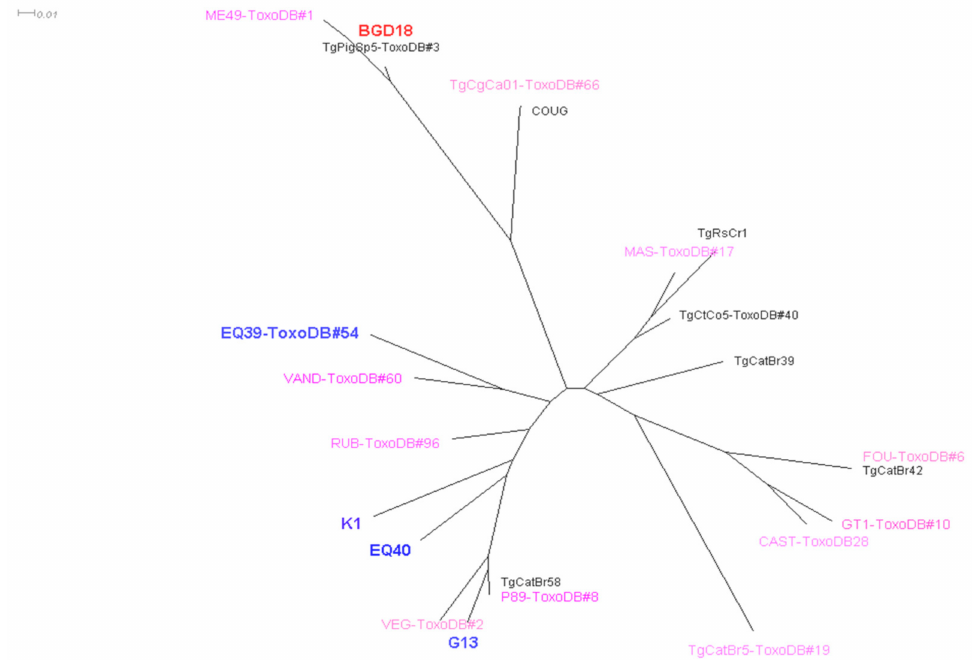
Figure 2. Neighbor-joining tree of T. gondii strains typed on a minimum of nine loci. Blue and red bold type indicates genotypes originating from Serbia, pink indicates reference strains, and black are isolates from Europe (TgPigSp5) and South